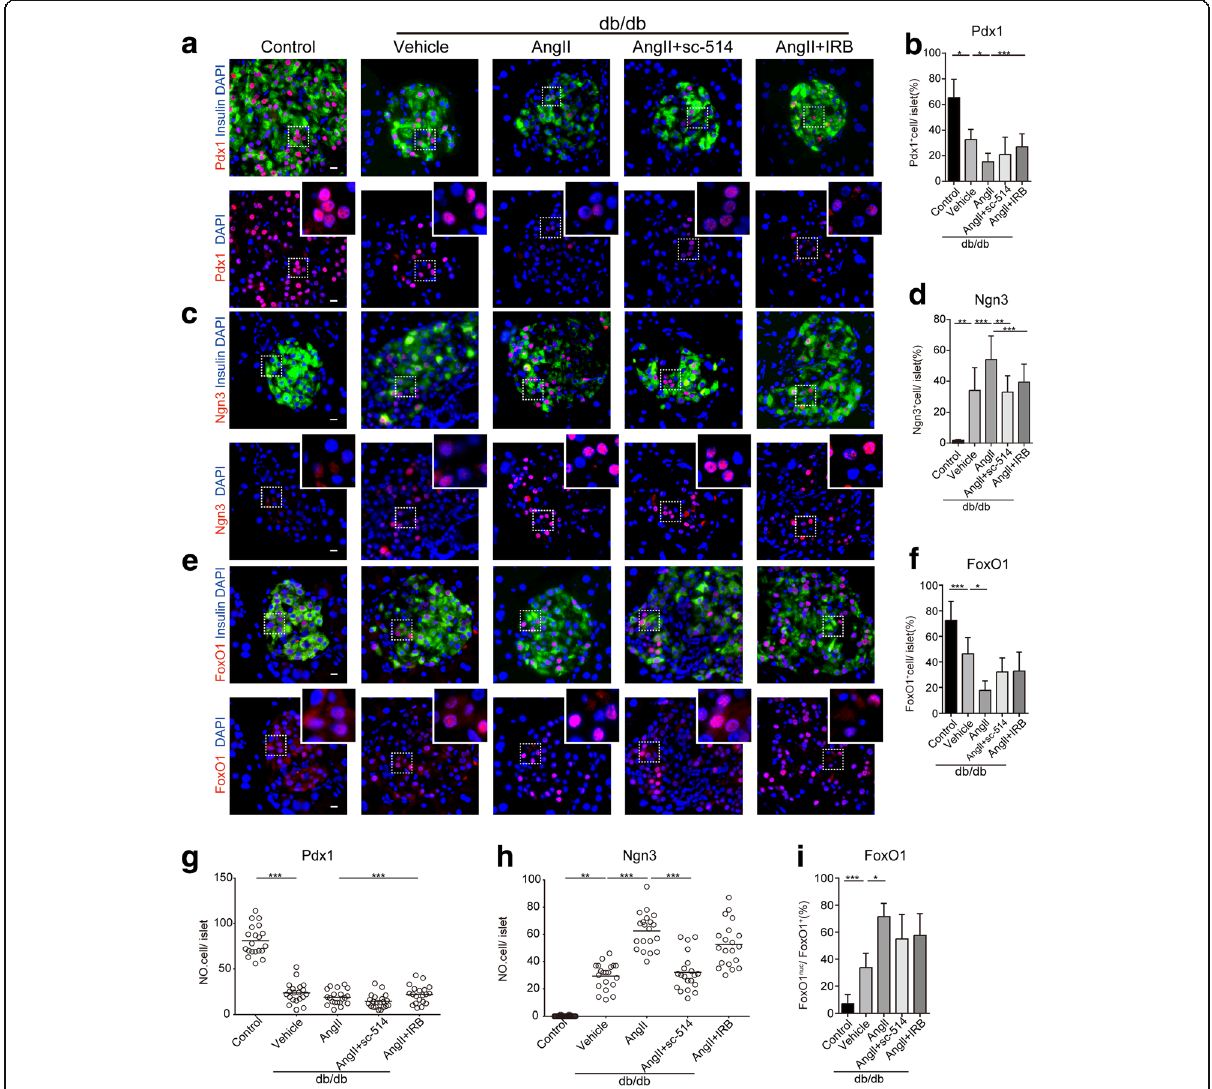
Fig. 5 (color; online only) sc-514 reversed β -cell dedifferentiation and dysfunction in db/db mice. a , c , e paraffin-embedded sections from the indicated groups were immunolabeled for insulin (green), PDX1 (red), insulin (green), NGN3 (red), insulin (green), FOXO1 (red), and DAPI (blue) ( b, d, f ) Quantification of labeled PDX1 or NGN3 or FOXO1 positive cells per islet. The squares (dashed white lines) show regions 9× enlarged and depicted as inserts at the top right of the corresponding images. g, h Numbers (NO.) of PDX1 or NGN3 positive cells. Scale bar (10 μ m). ( i ) Quantification of FOXO1 translocated to the nuclei of FOXO1-positive cells. For the immunofluorescence analysis: n ≥ 4 mice per group, n ≥ 20 islets per marker. Mean ± SEM * p < 0.05, ** p < 0.01, *** p < 0.001, one-way